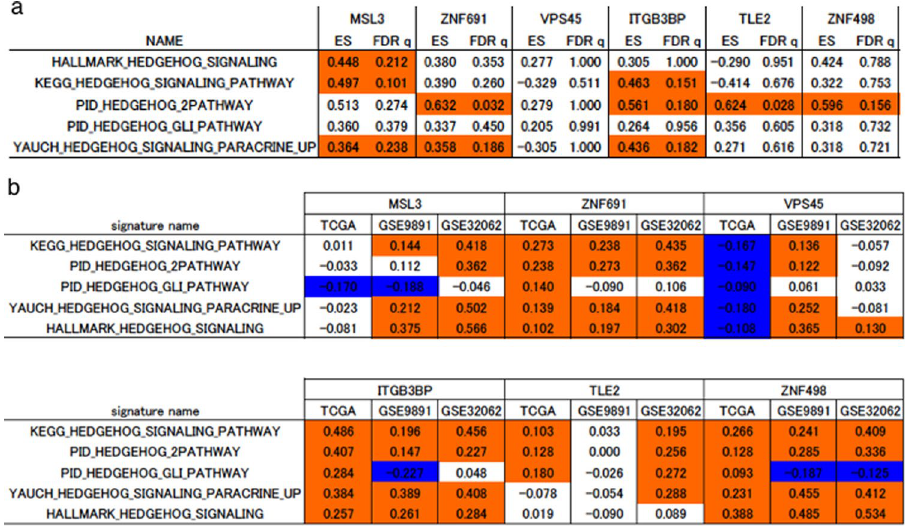
Figure 5. Strong relationships between the hedgehog pathway and six target genes are found. GSEA and ssGSEA analysis showing the relationships between the hedgehog pathway and six target genes. GSE32062 contains 260 patients with ovarian cancer. GSE9891 contain 285 patients with ovarian cancer. ( a ) Results of GSEA analysis. Enrichment score (ES) and FDR q value (FDR q) are shown. Red shading indicates significant enrichment for sh-target genes at an FDR q < 0.25. ( b ) Results of correlation analysis between the scores of the six gene signature and the hedgehog pathway-related signature. Red shading indicates a significant positive correlation (p < 0.05) and blue shading indicates a significant negative correlation (p <